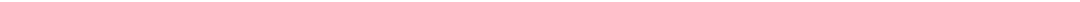
bars indicate standard deviations. Data are representative of six independent blinded experiments. An exemplary overlay fl uorescence image of optical stacks covering a partially viable wild-type hypha (green, GFP; red, trypan blue) is depicted on the left. a – c , f Bars represent 10 μ m and are applicable to